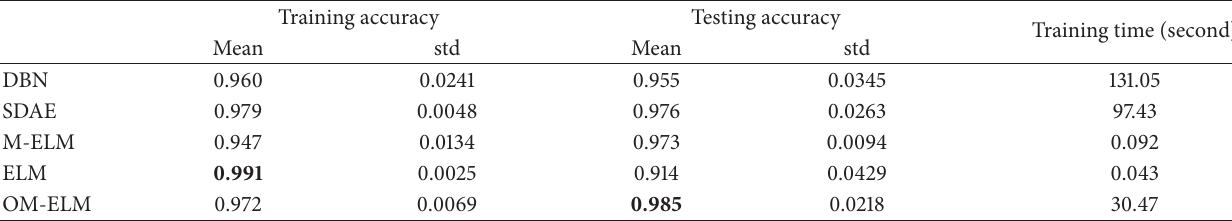
Table 4: Performance of all methods (noise level 𝑁 𝑙 = 0.05